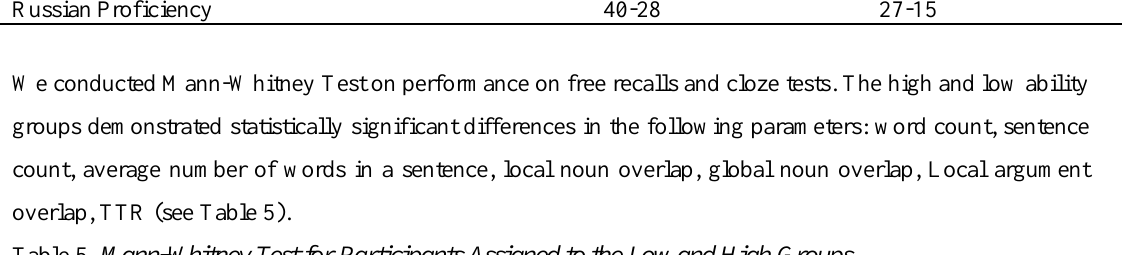
Table 5. Mann-Whitney Test for Participants Assigned to the Low and High